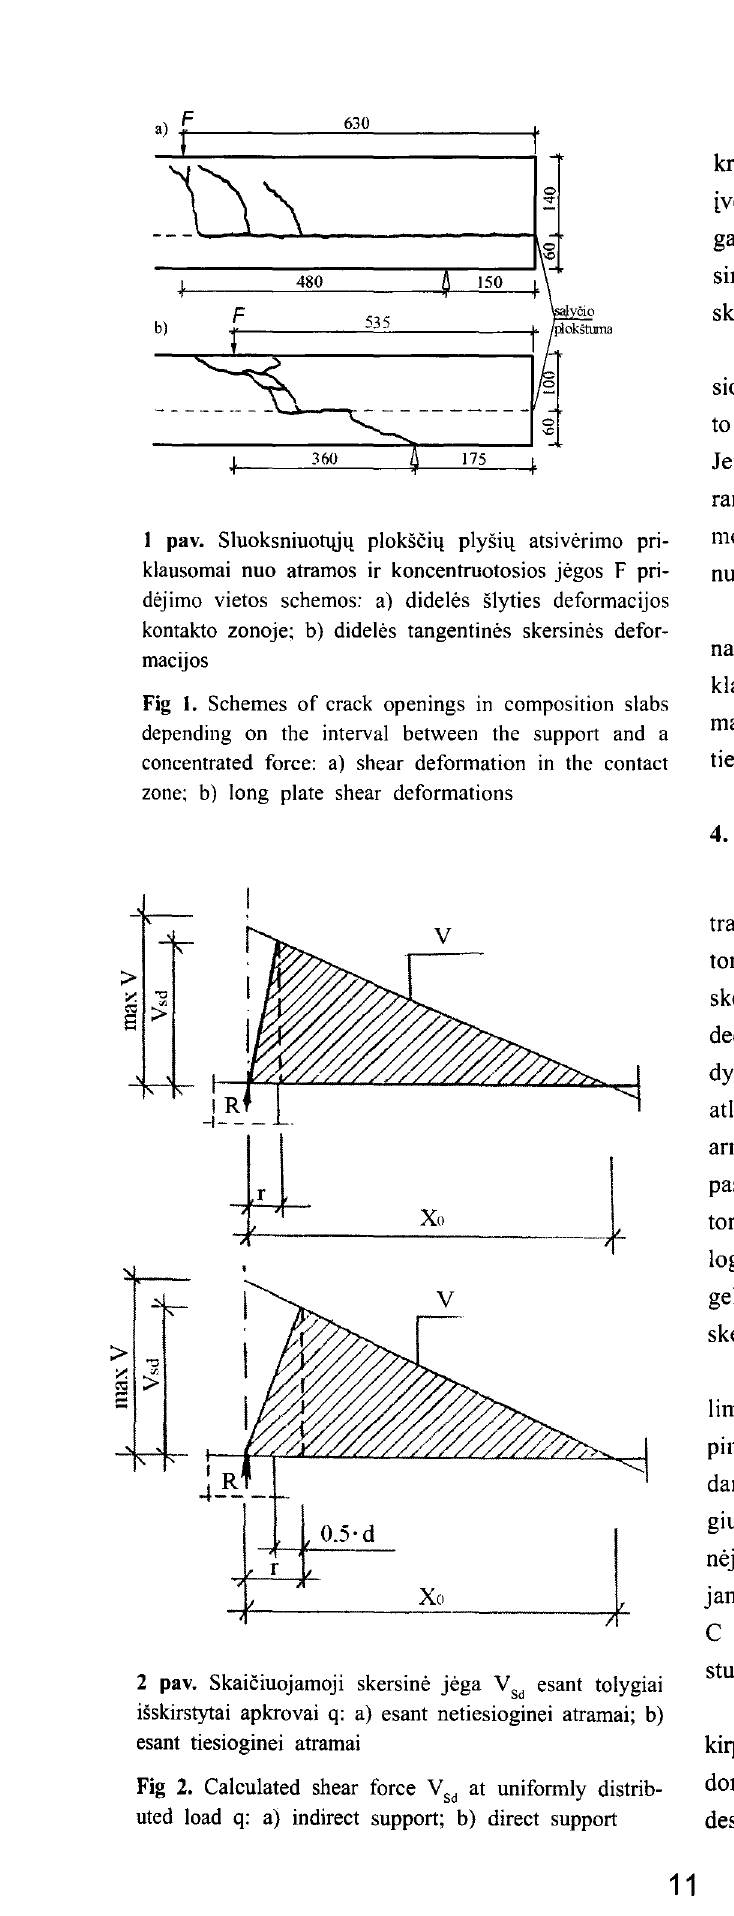
Fig 2. Calculated shear force V uted load q: a) indirect support; b) direct